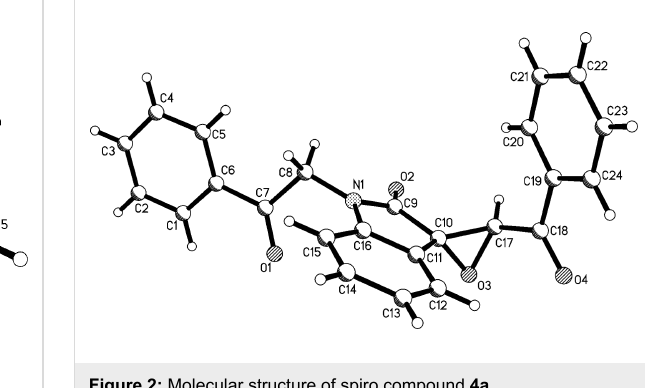
Figure 2: Molecular structure of spiro compound 4a . also established by spectroscopic methods and were confirmed by single-crystal X-ray structure determination of compound 5o (Figure 3). 1 H NMR spectra showed that a mixture of cis / trans isomers existed in most samples with a large range of different cis / trans ratios. It is known that the closure of the epoxy ring would form cis / trans isomers in the Darzens reaction process. Here the N -benzyl and the N -butyl group in the oxindole moiety may decrease the steric effect of formation of the epoxy ring and lead to the easier formation of the relatively unstable cis -